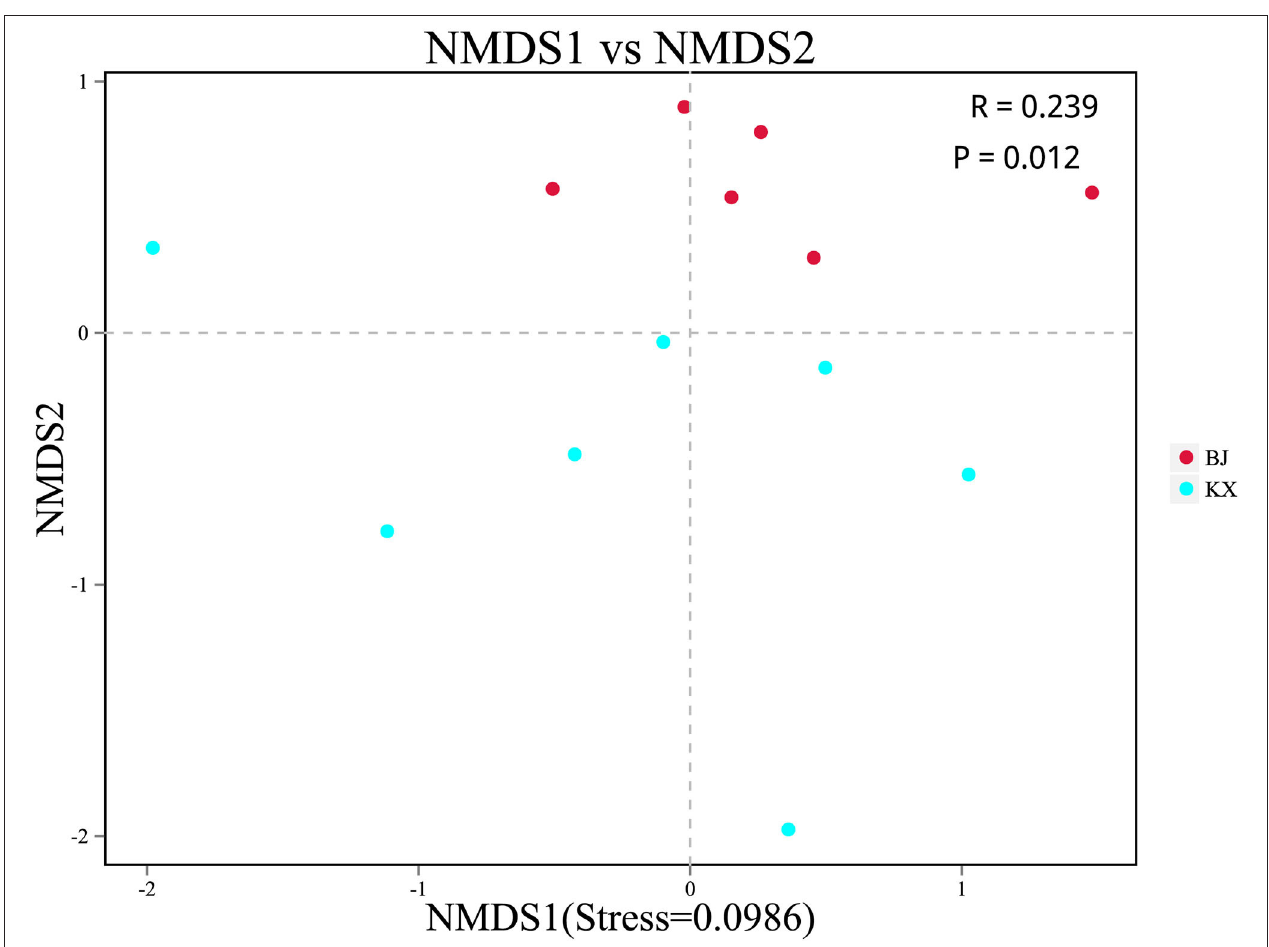
FIGURE 4 | Non-metric multidimensional scaling (NMDS) analysis. Each point represented one sample. The distance between points represented the degree of difference. The closer the distance between the samples in the graph, the higher the similarity between them. BJ, Bojiang Haizi; KX, Mu Us Desert.